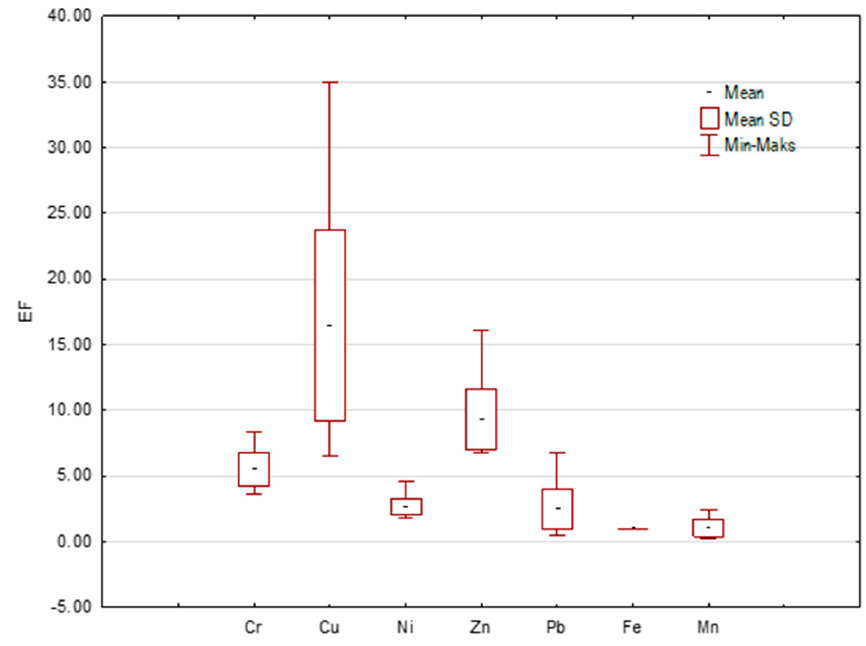
Figure 3. Assessment of level of pollution by enrichment factor (EF).